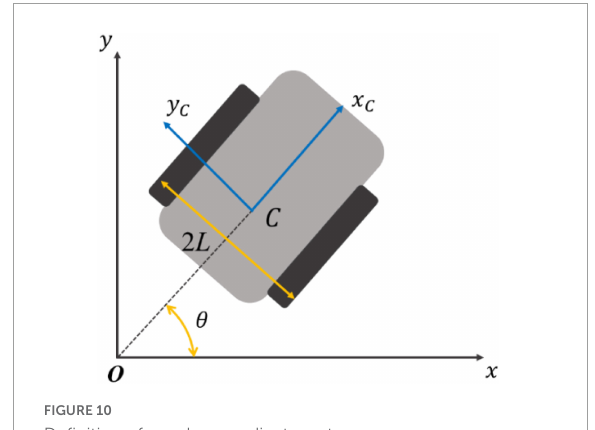
FIGURE10 Definition of crawler coordinate